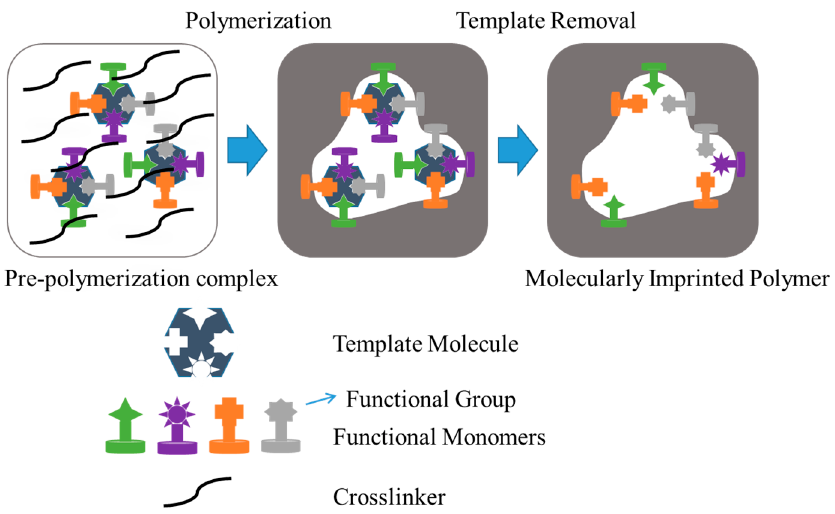
Figure 11. Scheme showing the different steps involved in the molecular imprinting process: Mixing of the appropriate template molecule and the selected functional monomer(s) and cross-linker(s) in a solvent; the polymerization of the formed complex; and finally the removal of the template, unreacted monomer, and cross-linker molecules. Adapted from [179].